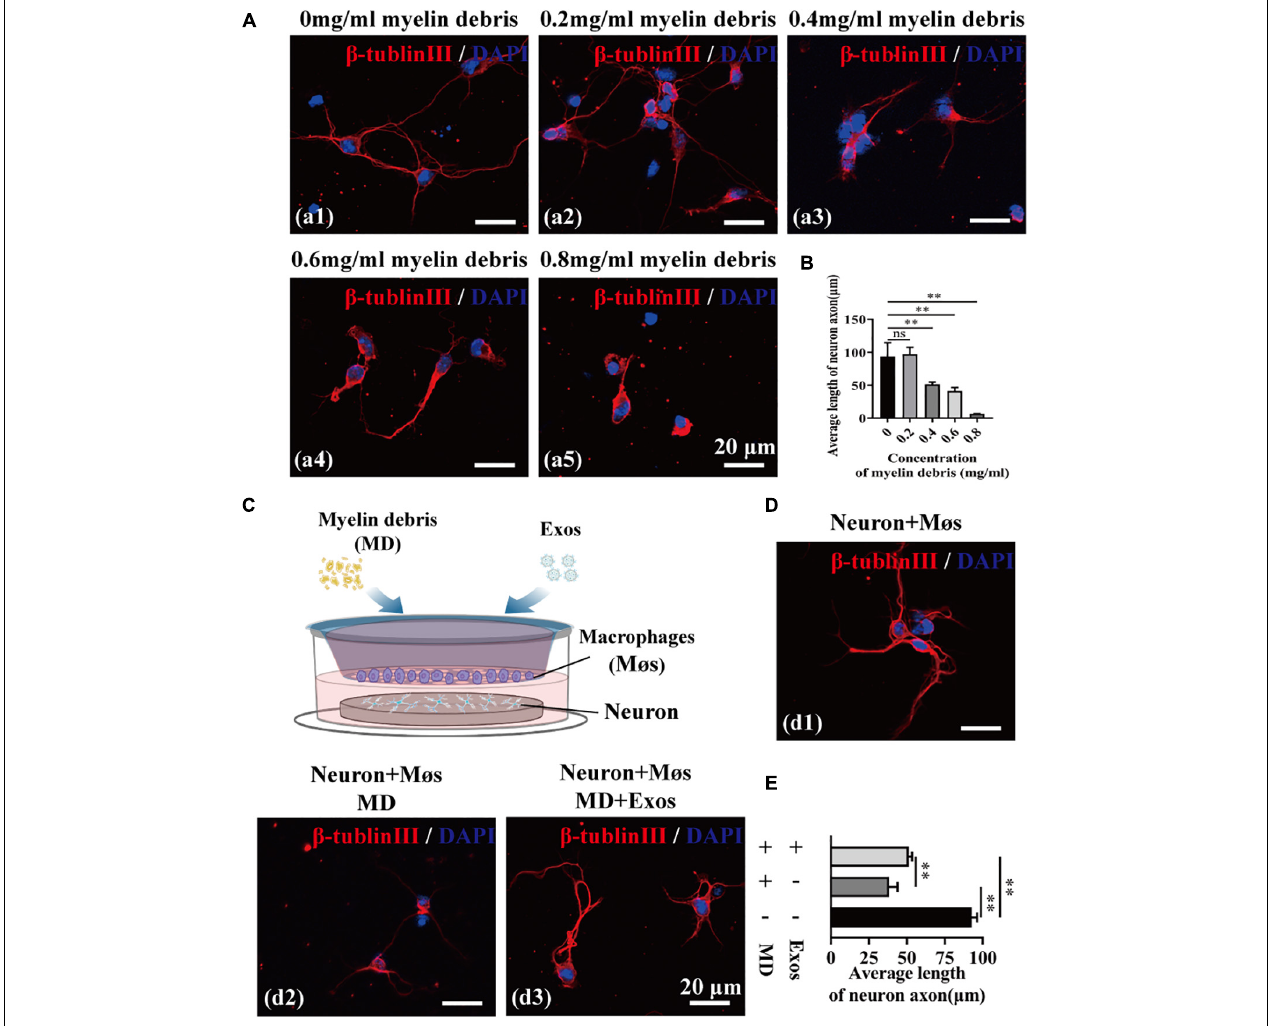
FIGURE 5 | Bone marrow mesenchymal stem cell-derived exosomes (BMSC-Exos) promoted macrophage phagocytosis of myelin debris and reduced the neurotoxicity of myelin debris in vitro . (A) Representative immunofluorescence images of the neuron marker β -tubulin III (red) to reveal the neurotoxicity of myelin debris for inhibition of axon growth at different concentrations. Nuclei were counterstained with DAPI (blue). Scale bar = 20 µ m. (B) Quantification of the axon length in (A) ( n = 3 per group; values are the mean ± SD, ns indicates no significance, ∗∗ p < 0.01, one-way ANOVA). (C) Schematic of the coculturing of myelin debris, macrophages, or BMSC-Exos with neurons. (D) Representative immunofluorescence images of neurons ( β -tubulin III, red) under different coculture conditions. Nuclei were counterstained with DAPI (Blue). Scale bar = 20 µ m. (E) Quantification of the axon length in (D) ( n = 3 per group; values are the mean ± SD, ∗∗ p < 0.01, one-way ANOVA). MD, myelin debris; Møs,